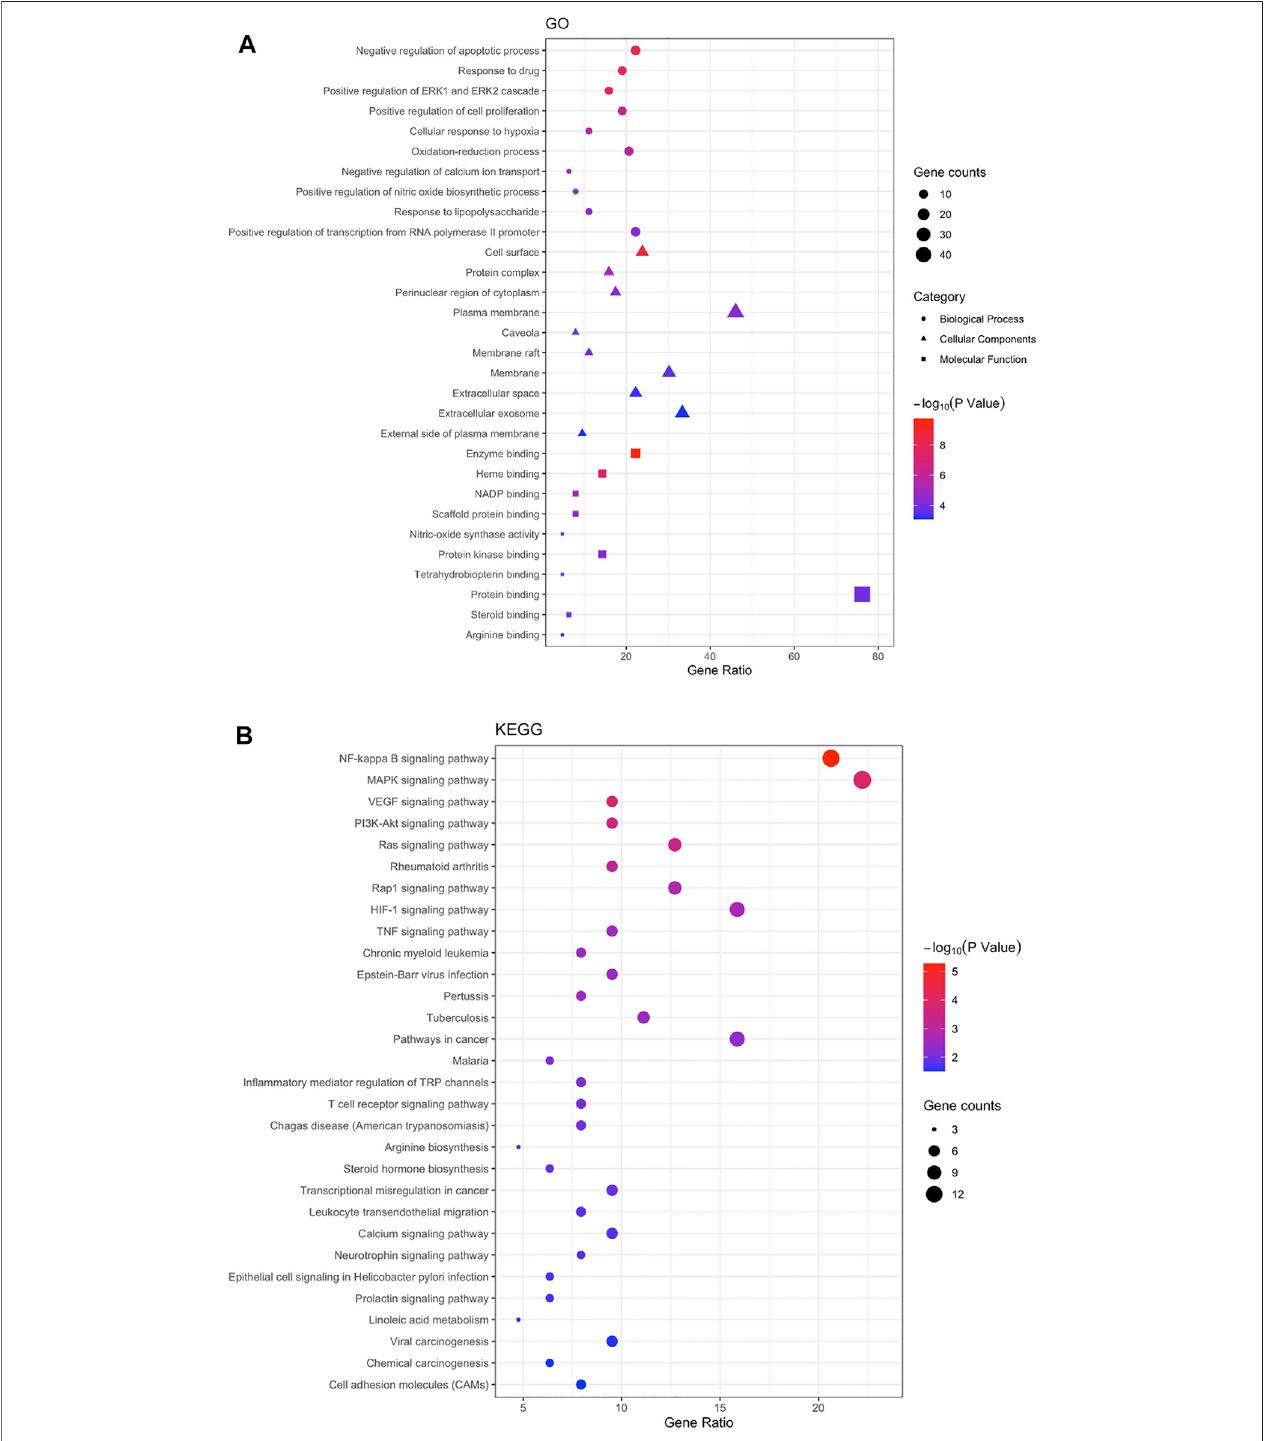
FIGURE4| TheGo (A) and KEGG (B) enrichment analysisofthetargets. 63 intersecting targets wereimported intoDAVID toscreenGO entries(BP, CC, MF)and KEGG signaling pathways with p < 0.05. A total of 150 BP, 31 CC, 46 MF and 35 signaling pathways were predicted, and we found that most of the key intersecting target were involved in the NF-Kappa B and MAPK signaling pathways.